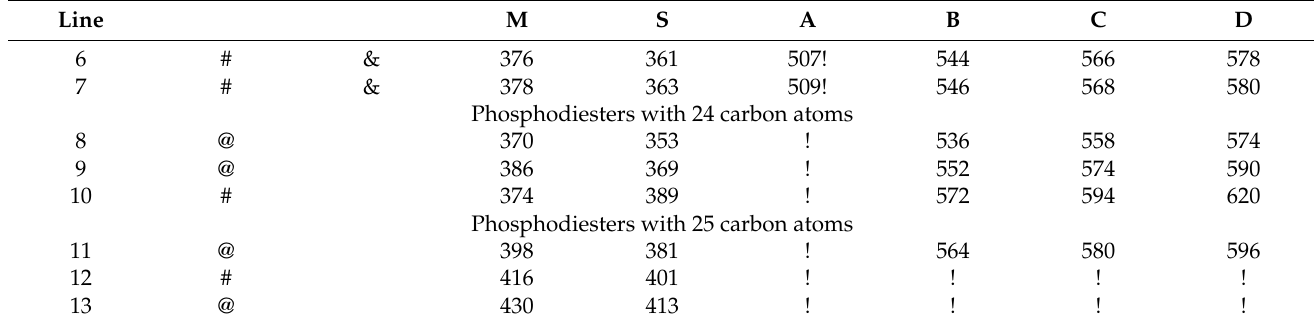
Symbols: M, Molecular mass of the steroid; S, Steroid fragment—formed by loss of PC (183 Da) from B; A, Loss of trimethylamine (59 Da) from C; B, H+ free acid; C, Na+ sodium salt; D, K+, potassium salt. Notes: @, These compounds are spiral steroids; #, The carboxylic acids must be protonated to be detected; &, Based on the absence of other ions in the mass spectrum, these six were judged to have been purified to near homogeneity; !, Ions that fit this pattern were not observed in the positive ion spectrum.